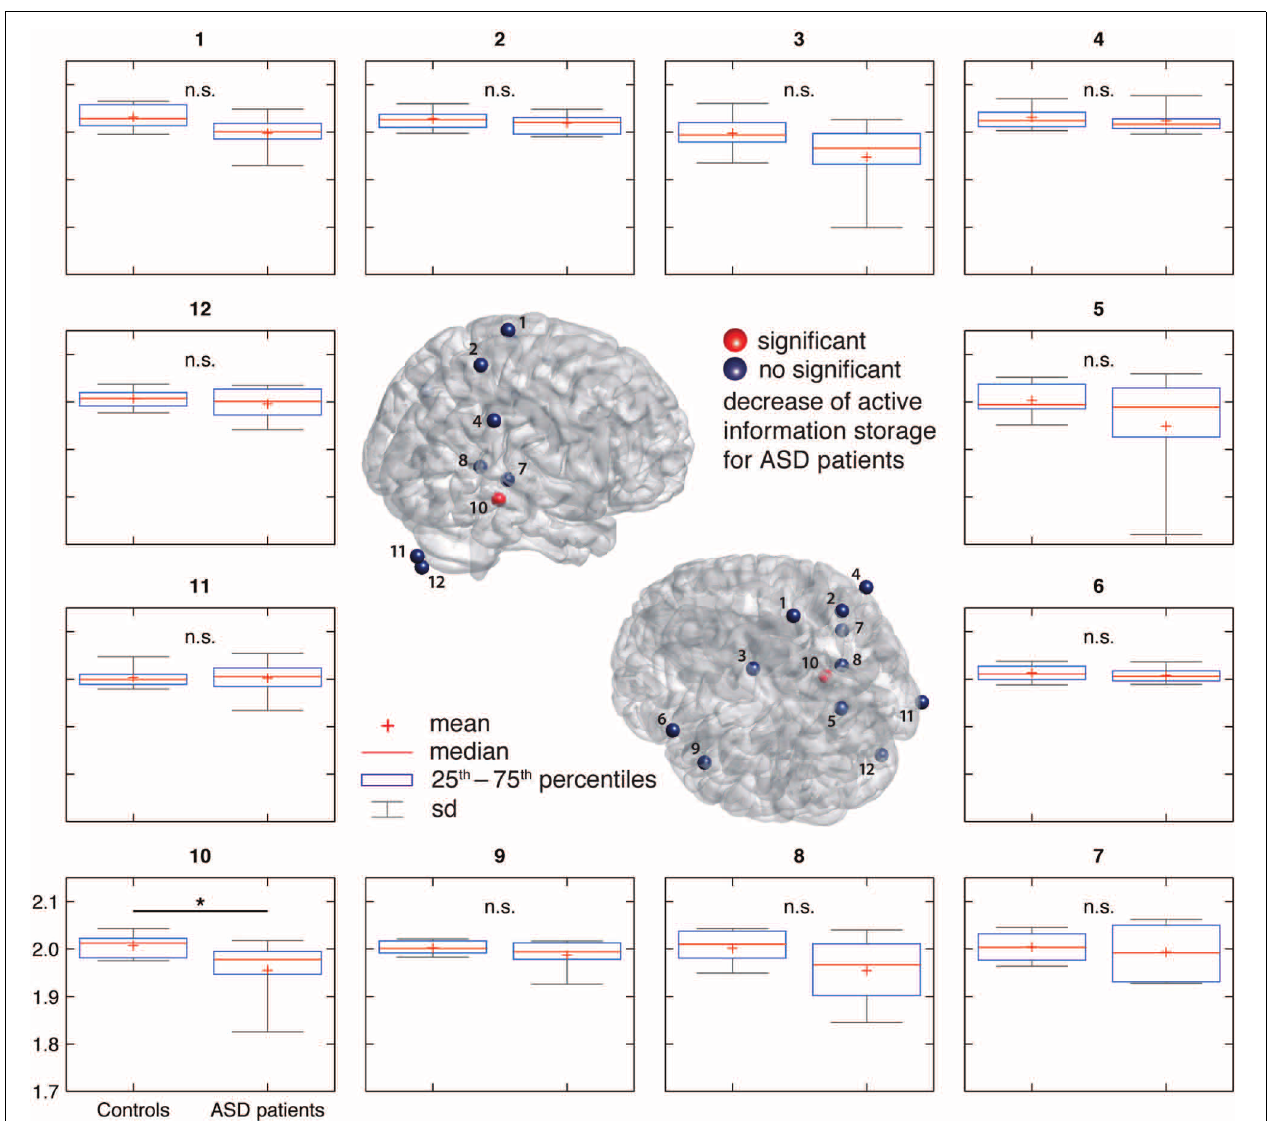
FIGURE 2 | Active information storage (AIS) results in ASD and control groups. (Center) Source locations (spheres) overlaid on a standard MNI brain. Sources are colored red or blue to indicate significant or non-significant